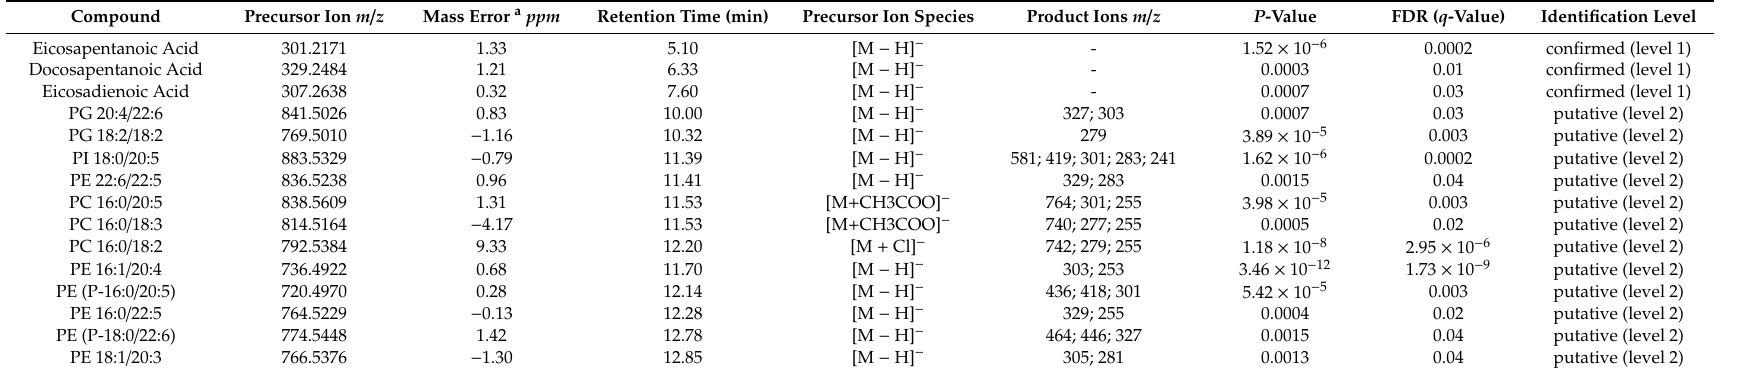
Table 2. List of metabolites significantly impacted by dietary